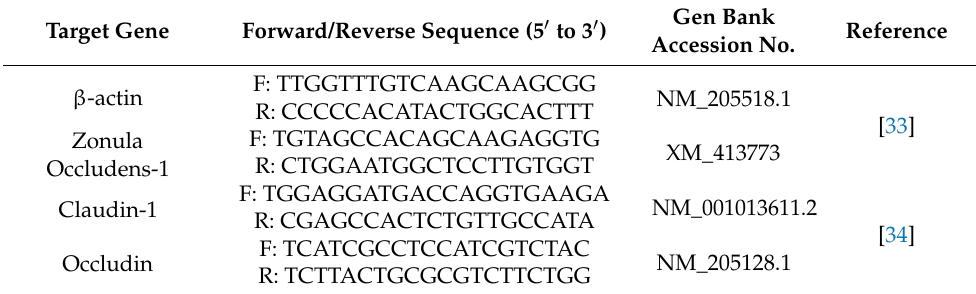
Table 3. Primers used for the quantitative RT-PCR of the target genes. Target